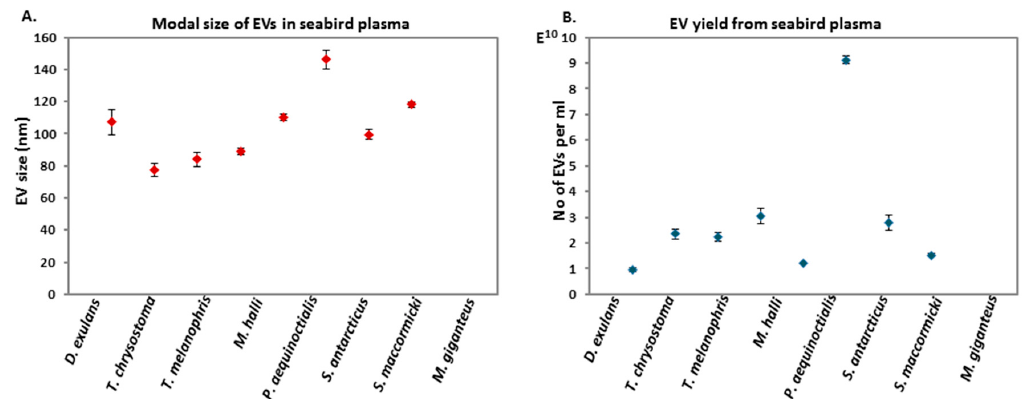
Figure 2. EV modal size and EV yield from plasma of the eight bird species. ( A ) Modal size of plasma-derived EVs varied between bird species but was overall in the range of 80–140 nm, with the largest modal size observed in south polar skua ( S. antarcticus ) and the smallest modal EV size in grey-headed albatross ( T. chrysostoma ). ( B ) Total yield of EVs isolated from plasma varied between the eight bird species, with the highest EV yield from south polar skua ( S. antarcticus ), but lowest EV yield from plasma of wandering albatross ( D. exulans ). For each species, EVs were measured in one individual per species, in five 60 s videos; each scatter dot therefore indicates the average of the five repeated readings per sample, and the error bars indicate +/ − standard error for these five readings of EV size distribution profile ( A ) and EV yield per sample ( B ).